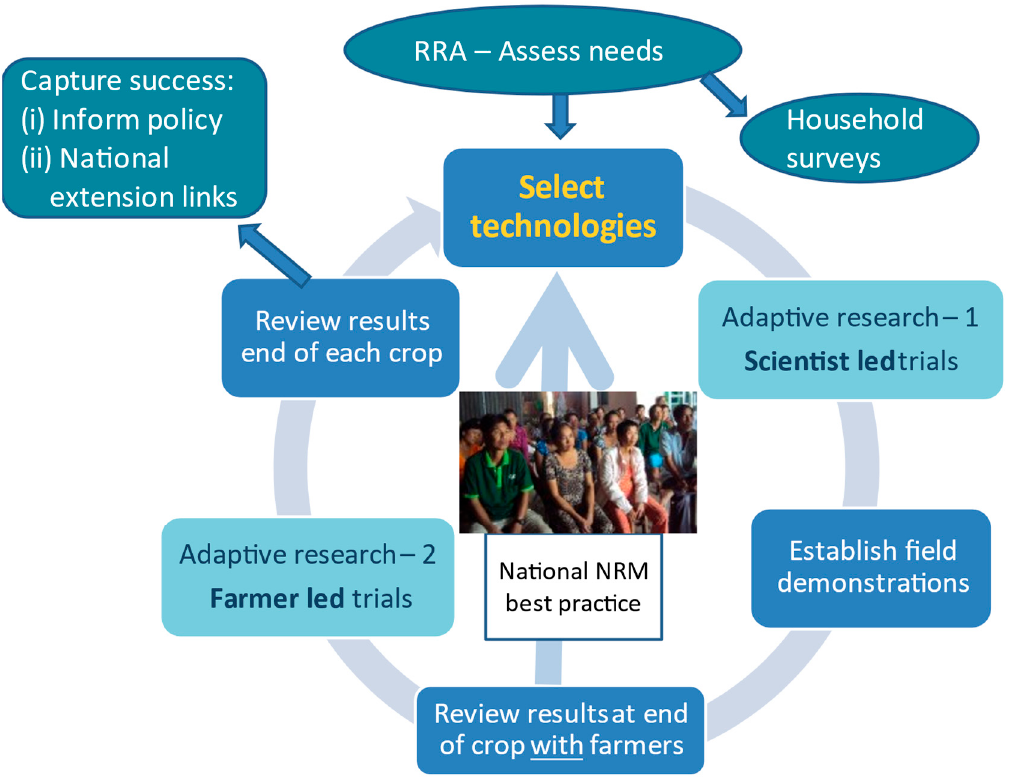
Figure 1. An outline of the adaptive research approach for developing evidence-based findings from trials conducted in the fields of farmers in the Mekong River Delta in Vietnam. (RRA = rapid rural appraisal; NRM = natural resource man- agement).